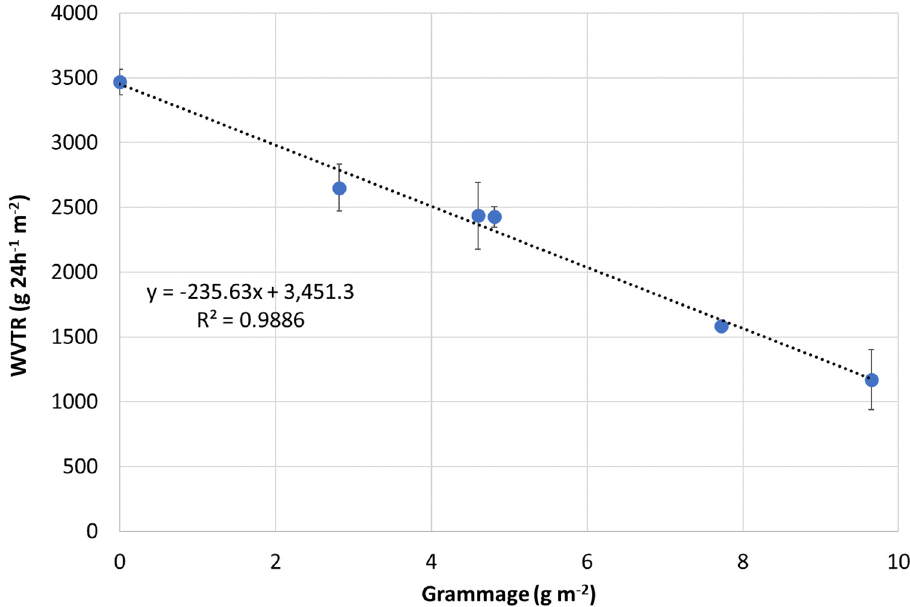
Figure 5. Linear correlation between coating grammage and WVTR of first set samples. Grammage equal to 0 corresponds to uncoated paper sample.